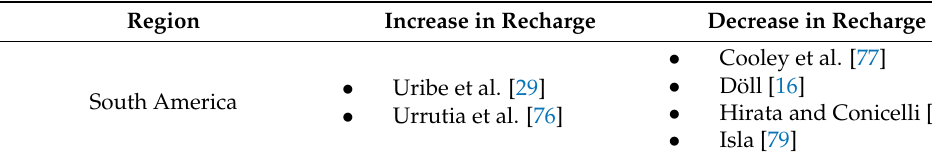
Table 2. Scientific production identified for South America.